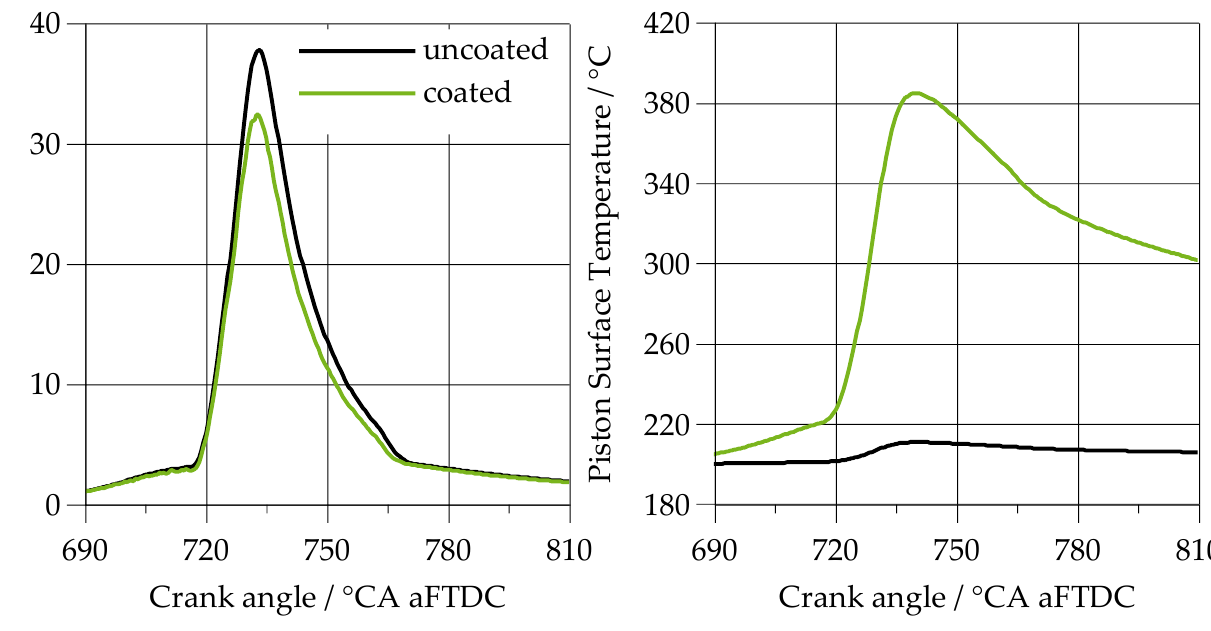
Figure 1. Piston surface temperature and piston heat transfer with and without thermal swing coating [2].